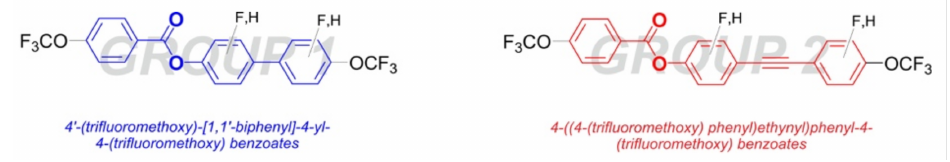
Figure 1. General structure of synthesized compounds.